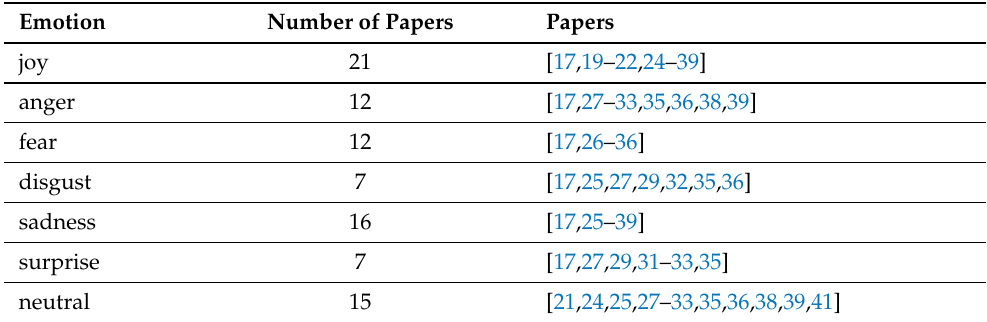
Table 3. Number of papers describing studies recognizing one of the emotions in Ekman model or neutral